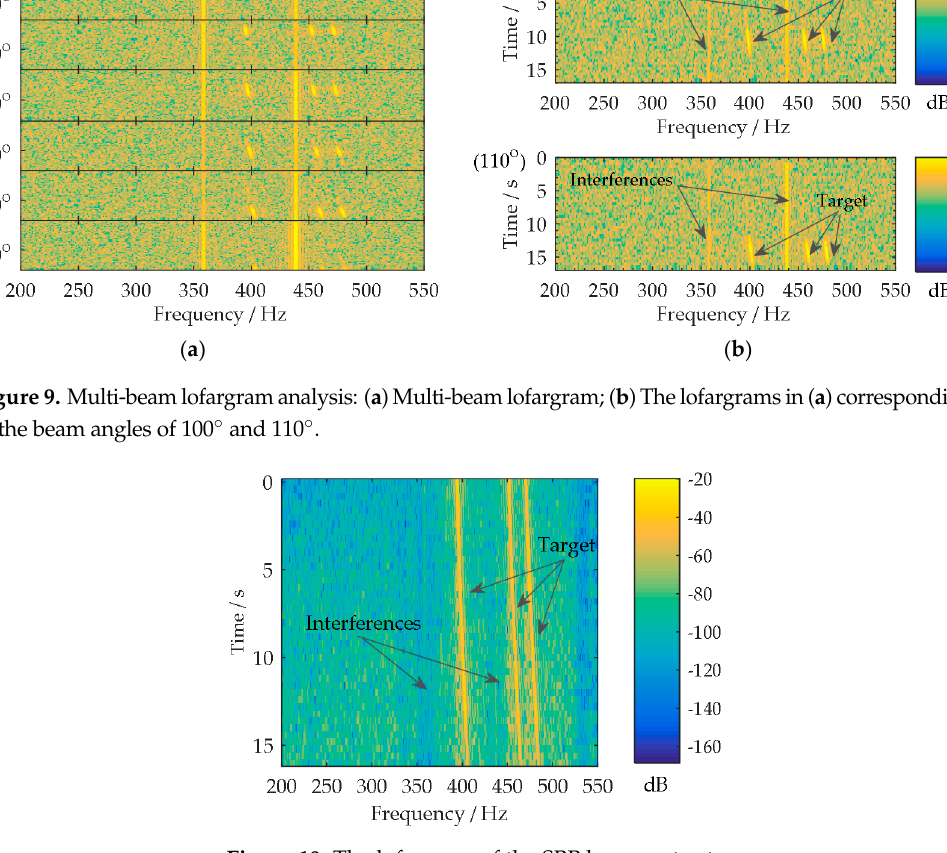
Figure 10. The lofargram of the SBB beam output.